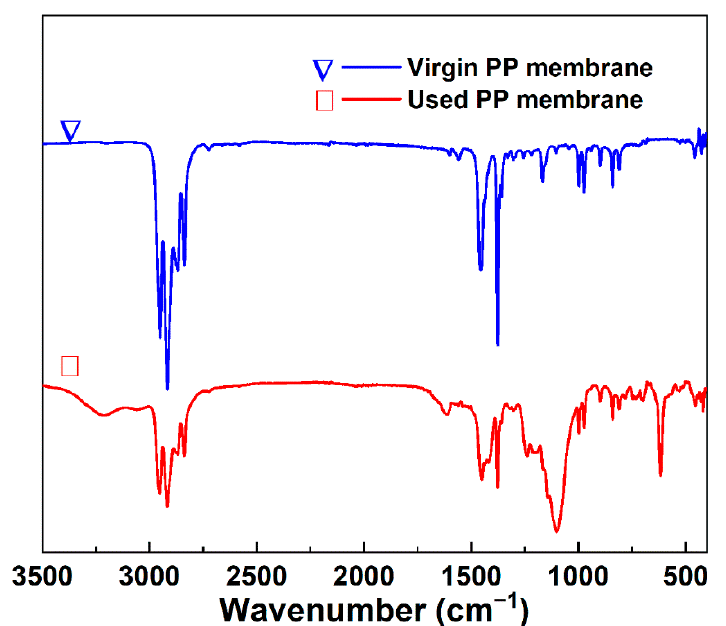
Figure 9. FTIR spectra of the virgin (blue line marked with a triangle) and used (red line marked with a square) PP hollow fiber membrane samples.